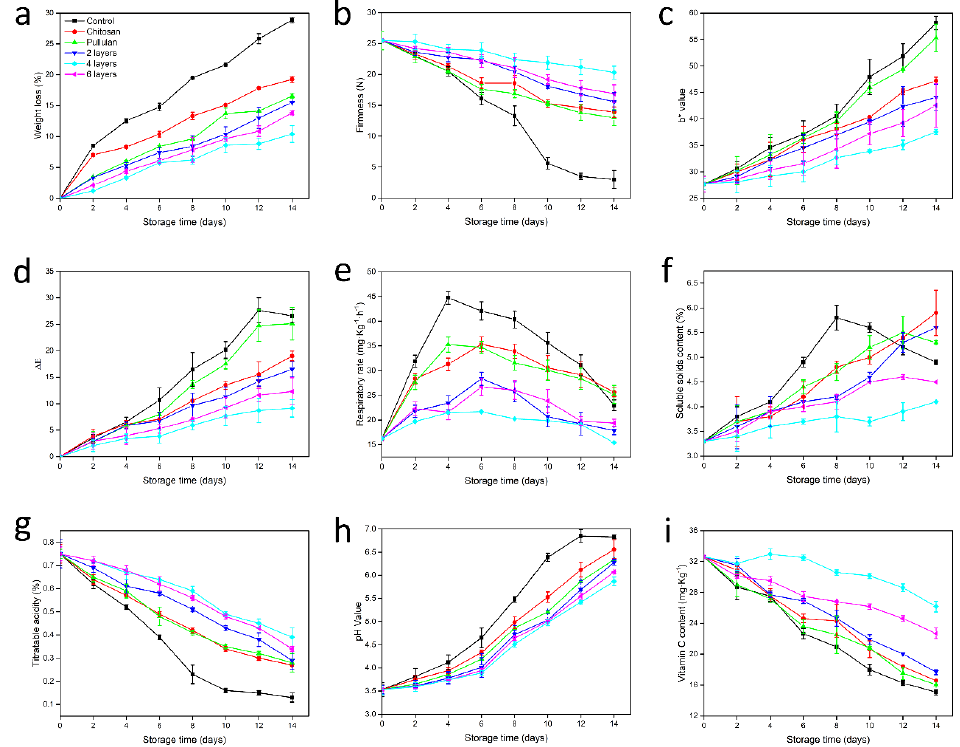
Figure 1. Effect of pullulan-chitosan multilayer coatings on ( a ) weight loss; ( b ) firmness; ( c ) b * value; ( d ) Δ E ; ( e ) respiratory rate; ( f) SSC; ( g ) TA; ( h ) pH and ( i ) VC of papayas stored at 25 °C and 50% RH for 14 days. Vertical bars represent the standard errors of the means.